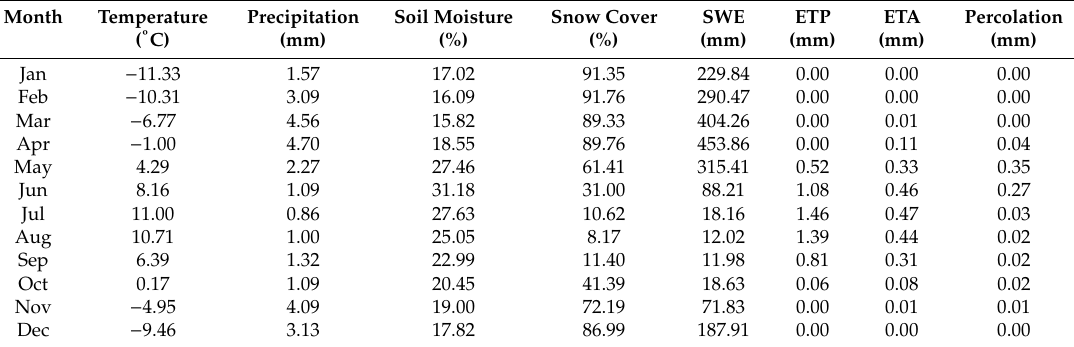
Figure 8. Comparison of simulated and observed daily river discharge of Astore River for the calibration and validation periods. Table 4. Average monthly flow statistics of flow simulation during the validation period 2001–2003.